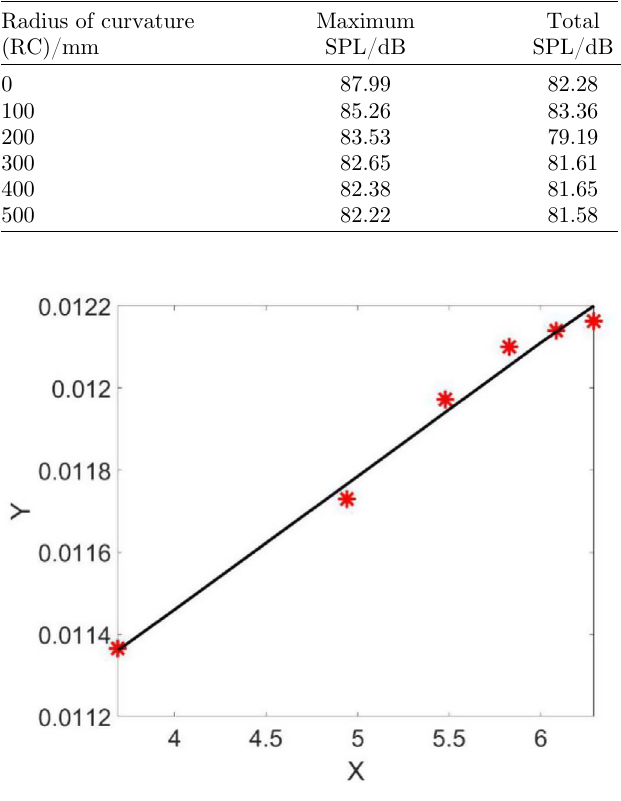
Figure 15. The scatter diagram and the linear fi tting of Y and X.